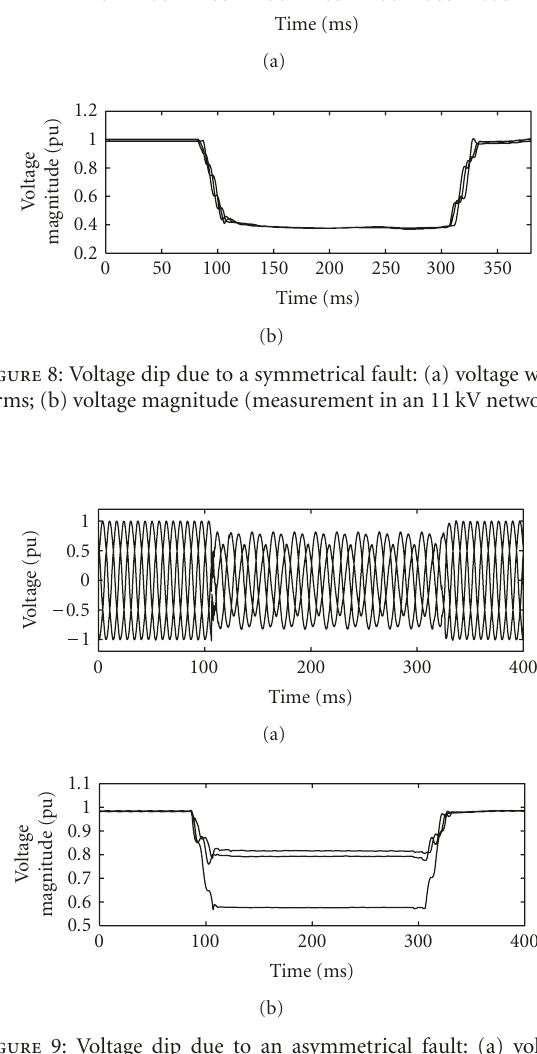
Figure 9: Voltage dip due to an asymmetrical fault: (a) voltage waveforms; (b) voltage magnitude (measurement in an 11 kV net- work).